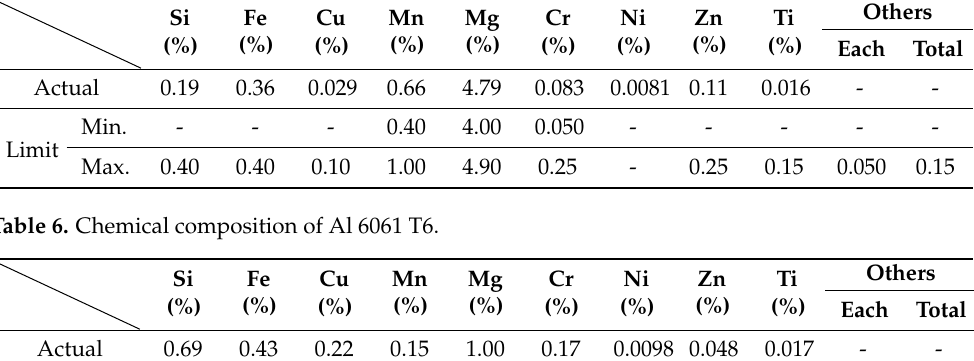
Table 6. Chemical composition of Al 6061 T6.